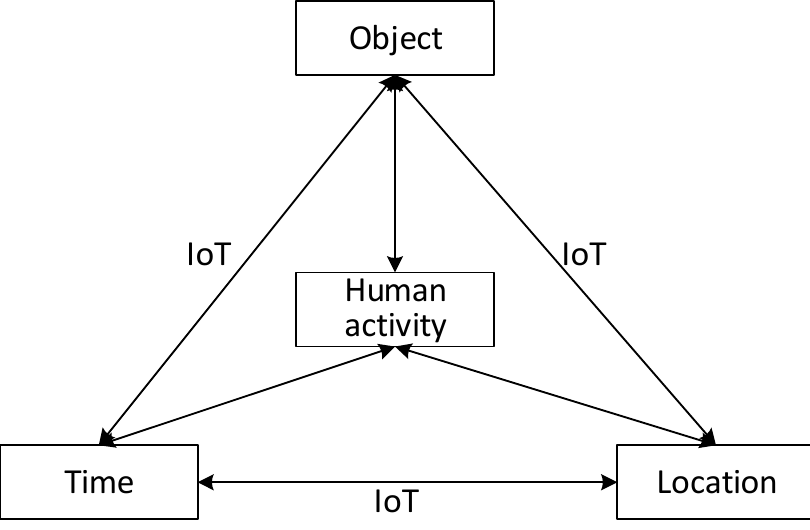
Figure 1. Four-dimensional model of smart community system.